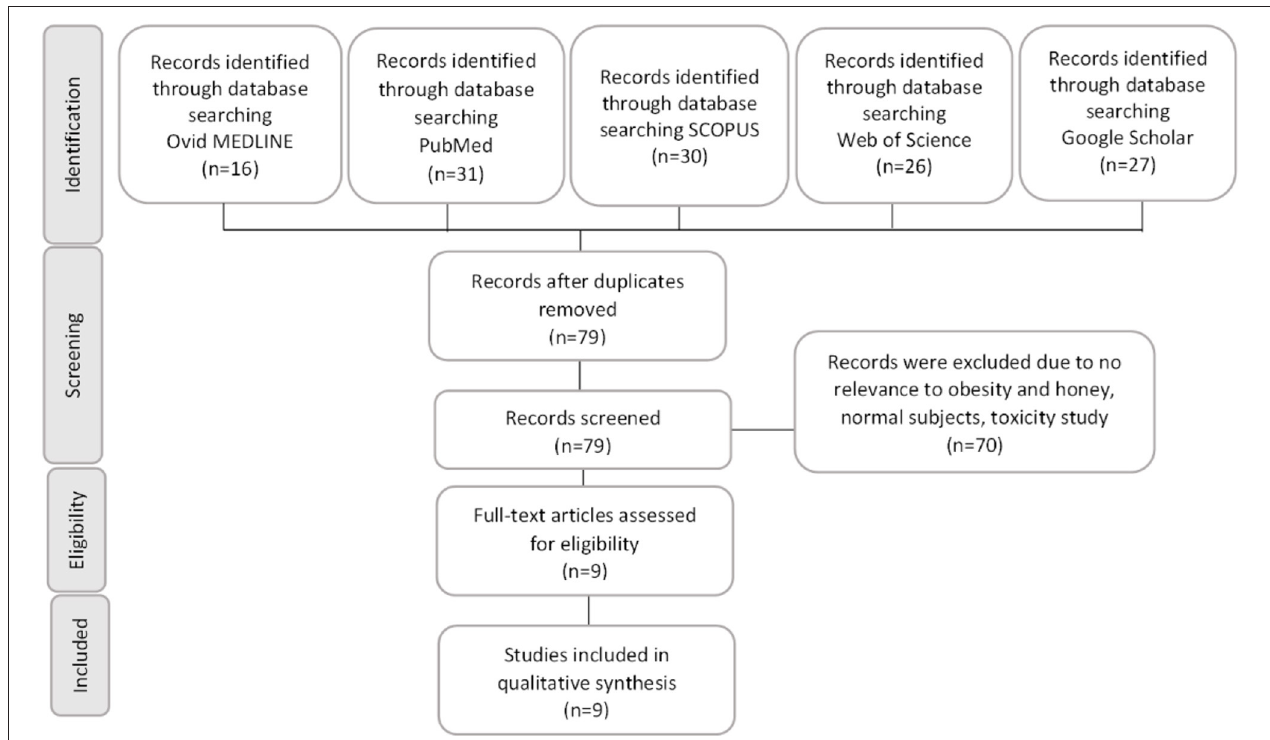
FIGURE 1 | A summary of the literature search and the steps involved in the study selection according to the Preferred Reporting Items for Systematic Reviews and Meta-Analyses (PRISMA) guideline. Overall, nine studies met the search criteria.